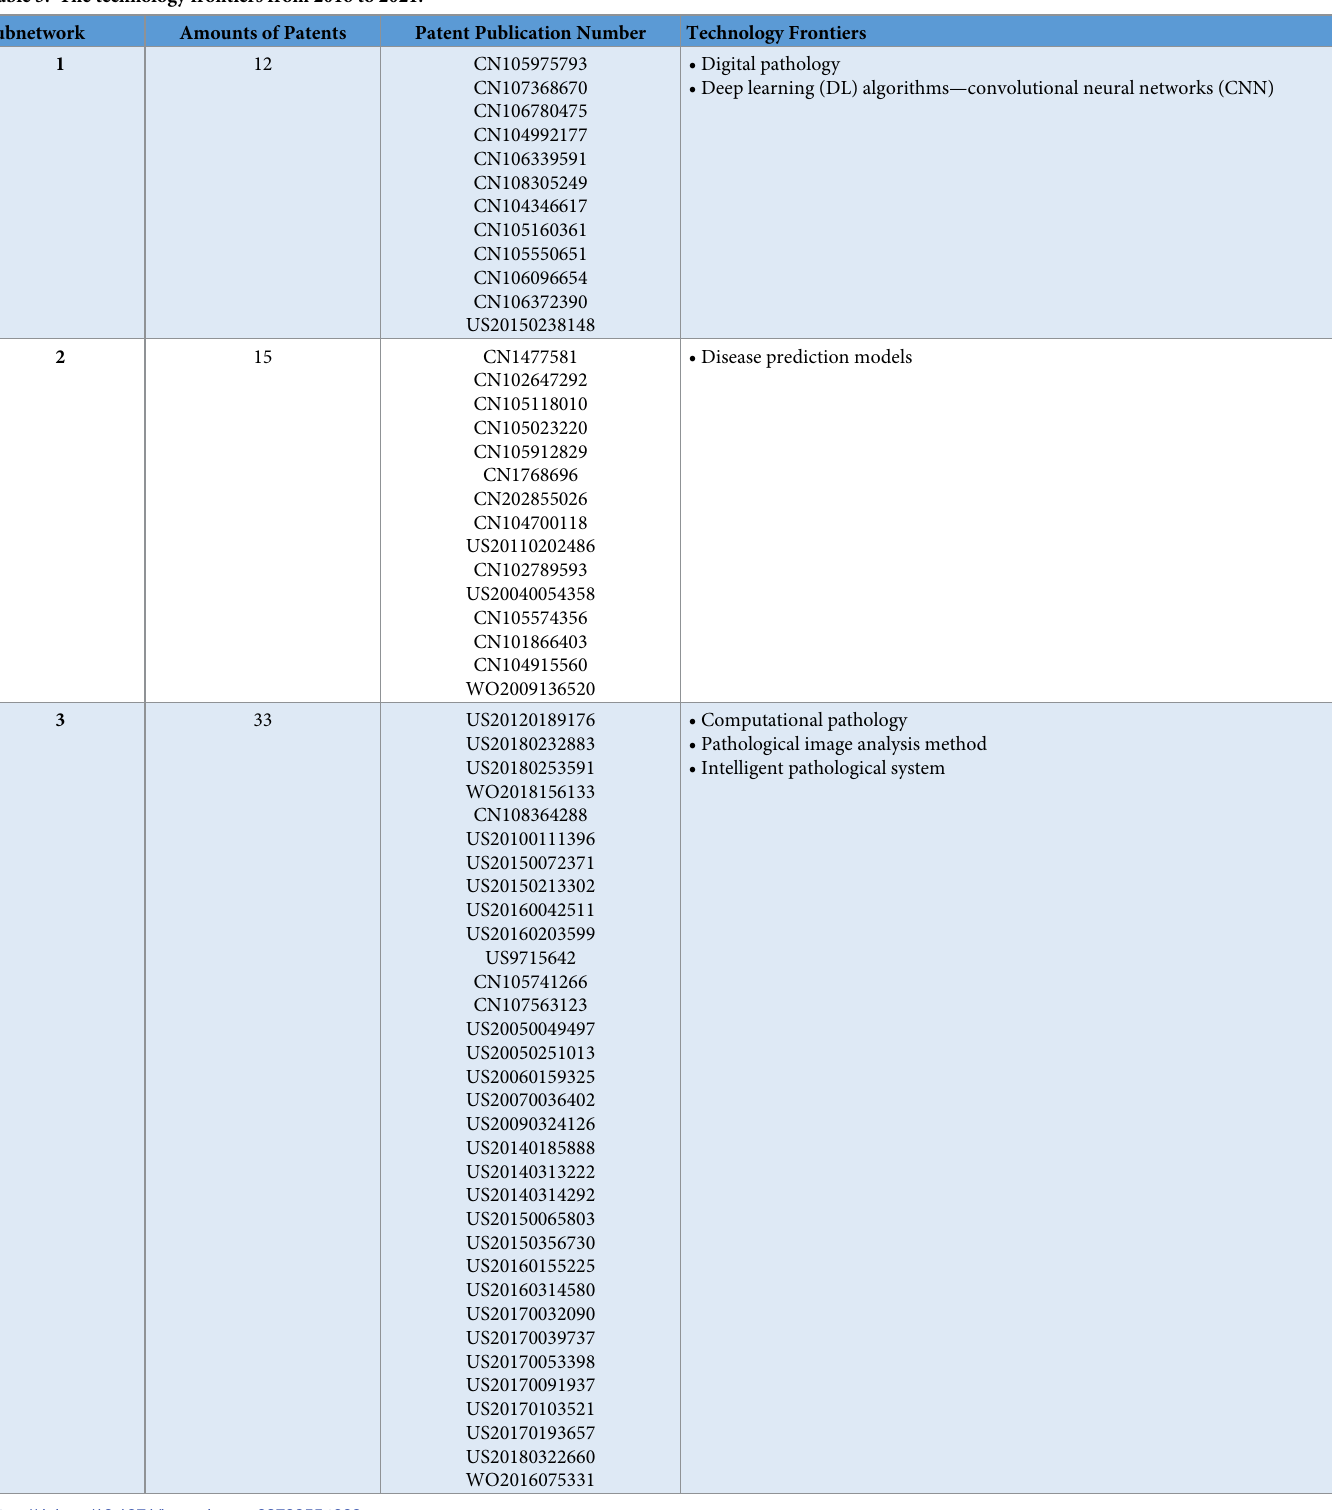
Table 3. The technology frontiers from 2016 to